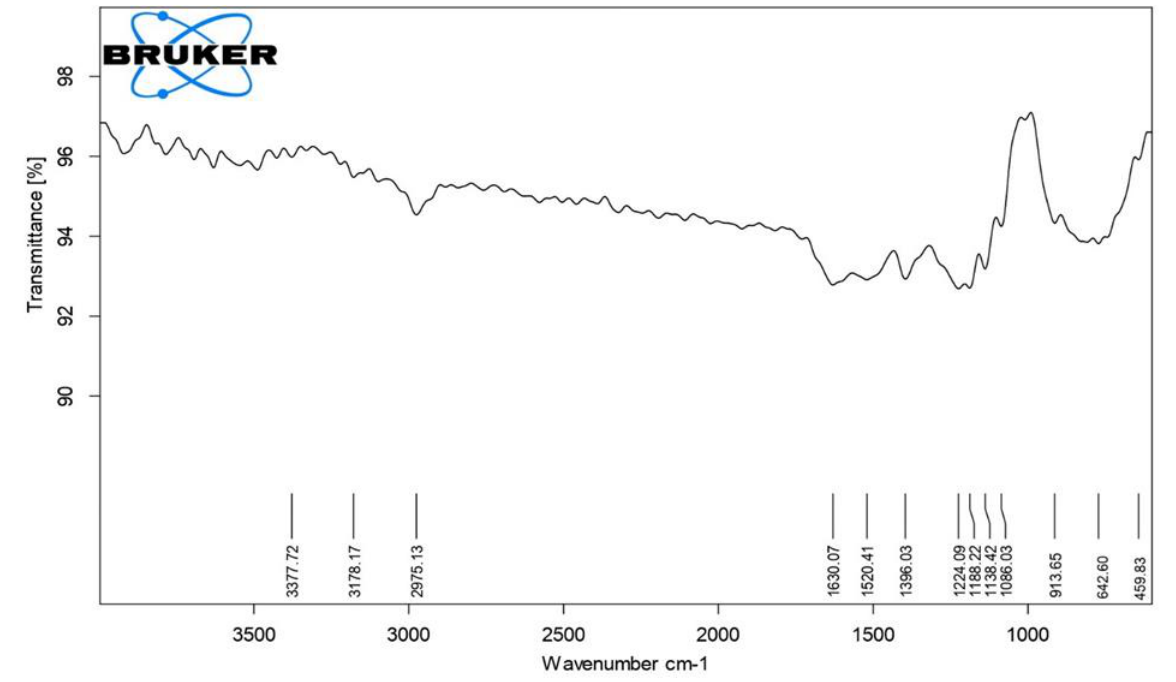
Figure 3. FTIR spectrum of TP-mediated ZnO NPs.